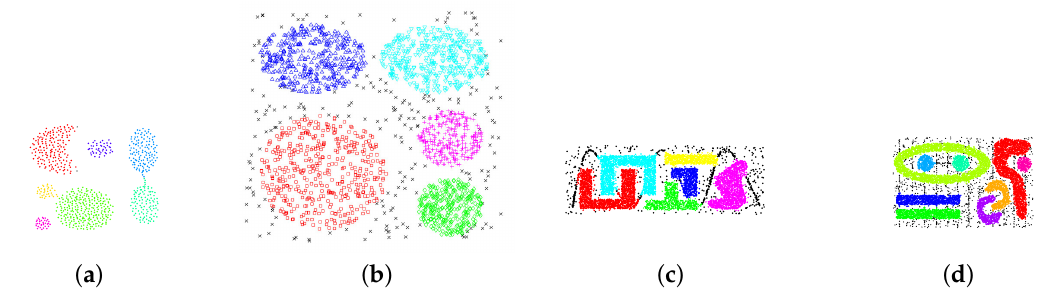
Figure 6. Clustering effect of improved DBSCAN on four data sets. ( a ) Aggregation. ( b ) DS1. ( c ) t4.8k. ( d ) t7.10k.